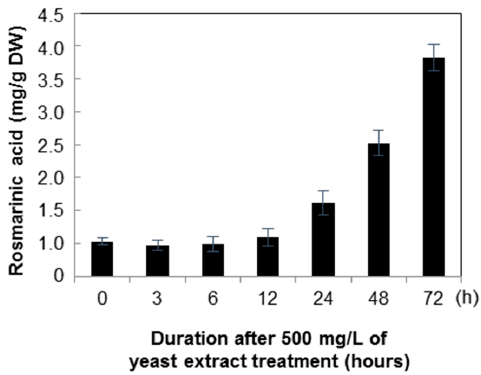
Figure 8. Time course of rosmarinic acid content in Agastache rugosa callus treated with 500 mg/L yeast extract. The levels of rosmarinic acid in each sample were analyzed by HPLC. Error bars show standard deviation values.